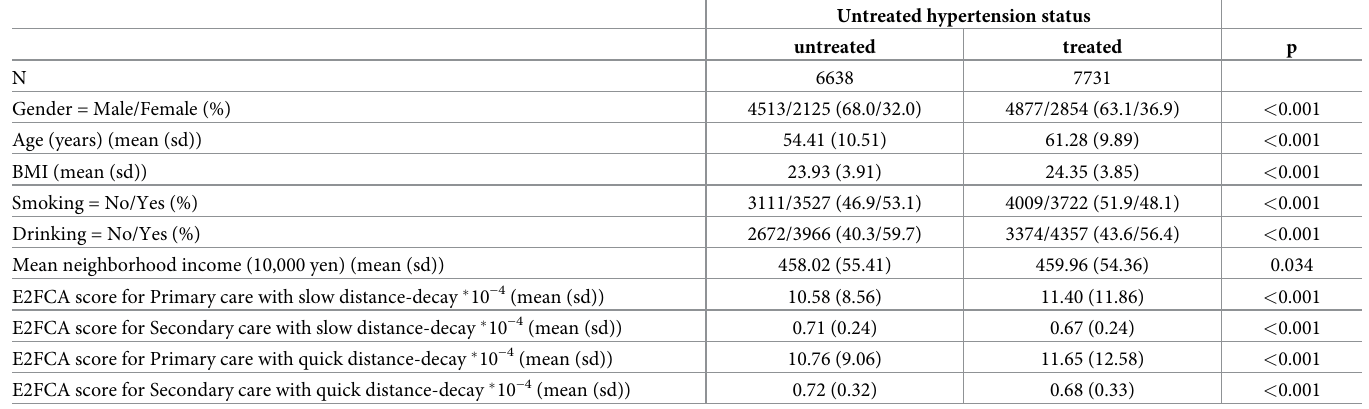
Table 2. Descriptive statistics of study samples by untreated hypertension